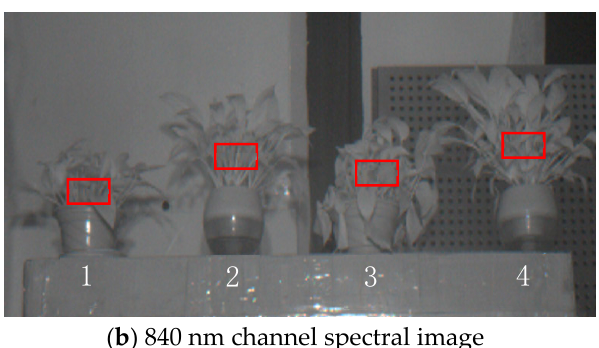
Figure 13. Multi-spectral photos with 2.85 m radiation range. Table 8. Test data comparison.